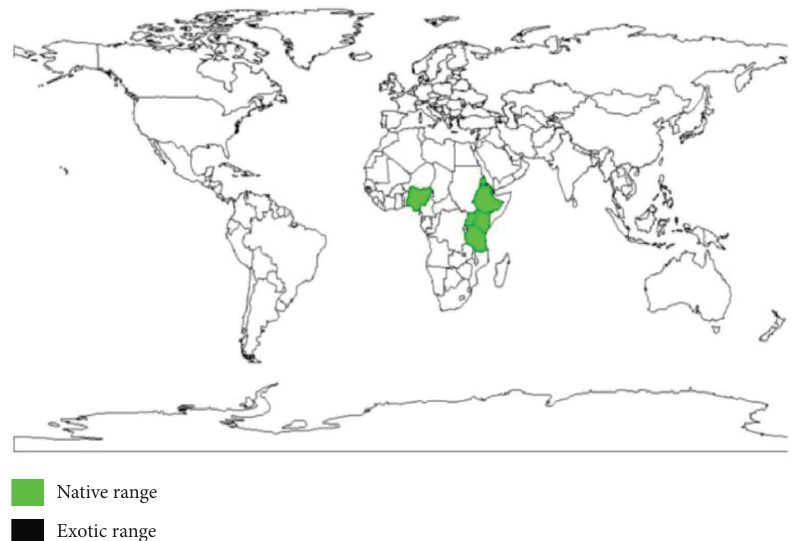
Figure 1: Croton macrostachyus hochst ex. delile species geographical distribution [Orwa et al. [20]].